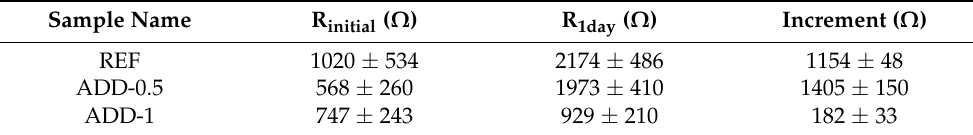
Table 2. Electrical resistance values of sensors at different hydration times: initial and after 1 day.